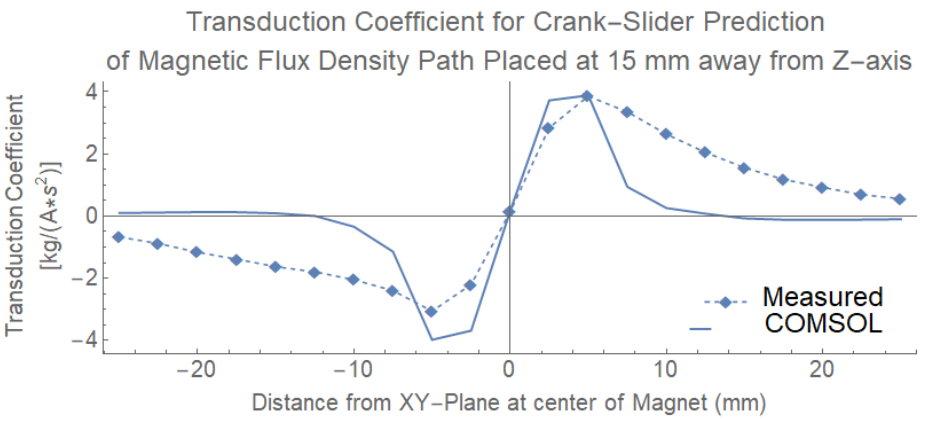
Figure 10. A sample of values for B through the coil along the axis of oscillation. The measured values were physically collected using a WT10 Teslameter at the indicated distances. The COMSOL values were extracted from Figure 9 at a distance of 15 mm from the z -axis (the center of the magnet) and along the axis of oscillation extending ± 25 mm from the XY-plane.